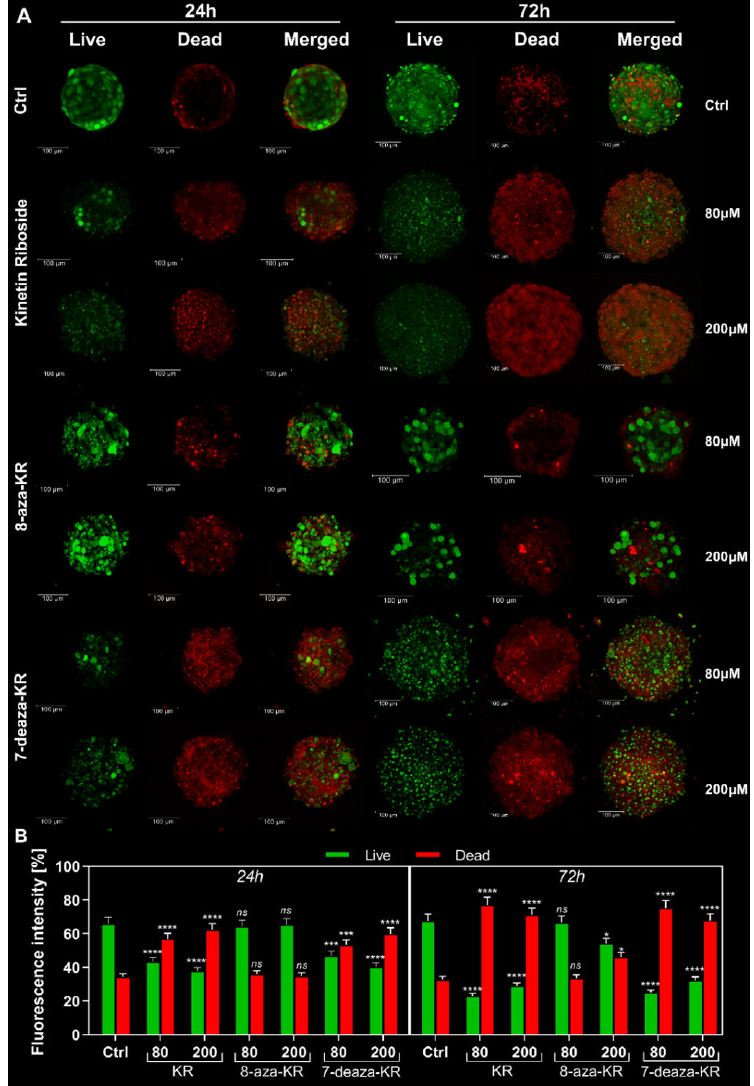
Figure 3. Viability analysis of T98G spheroids after treatment with KR and 7-deazaKR treatment. ( A ) Confocal microscopy analysis of the viability of T98G cells in 3D culture by using the LIVE/DEAD assay kit. Green (ex/em: 490/505–550 nm) and red fluorescence (ex/em: 530/600–660 nm) corre- spond to live and dead cells, respectively. Merged images are shown on the right panels. ( B ) Analysis of the fluorescence intensity of spheroids. The results are presented as mean ± SD of three inde- pendent measurements. Statistical significance (two-way ANOVA): (ns) not significant, * p < 0.05, *** p < 0.001, **** p <